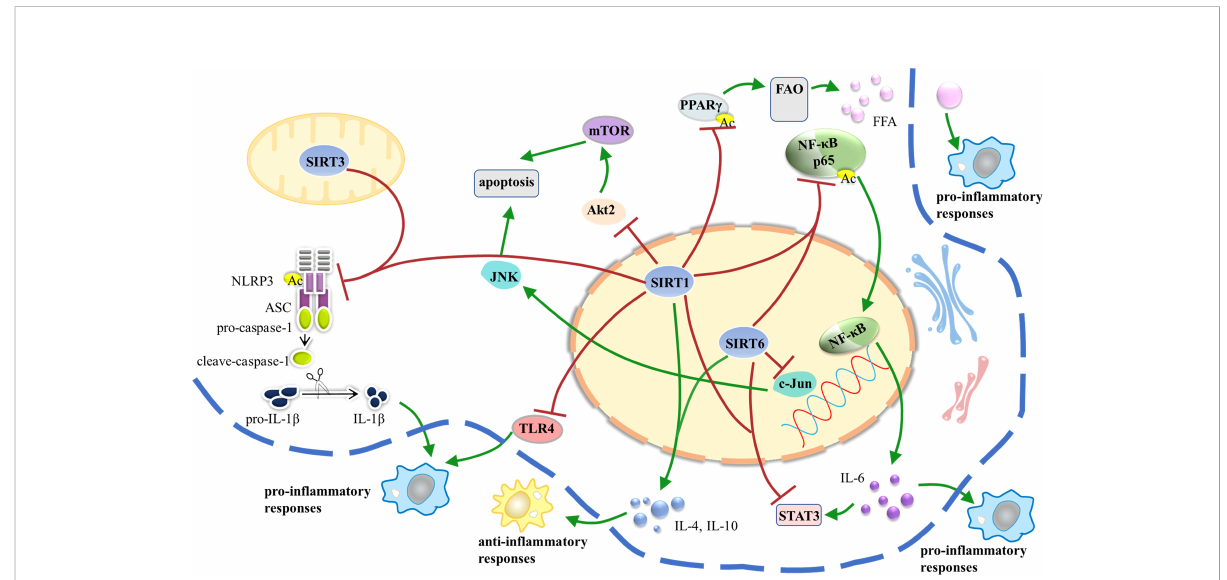
FIGURE 3 SIRT1, SIRT3, and SIRT6 participate in the regulation of AT in fl ammation via different pathways. AT in fl ammation is initiated and sustained over time by dysfunctional adipocytes that secrete in fl ammatory adipokines and by in fi ltration of bone marrow-derived monocytes that signal via production of cytokines and chemokines. White AT is the major source of obesity-related in fl ammation; in turn, AT in fl ammation leads to IR and metabolic dysfunction. AT, adipose tissue; IR, insulin